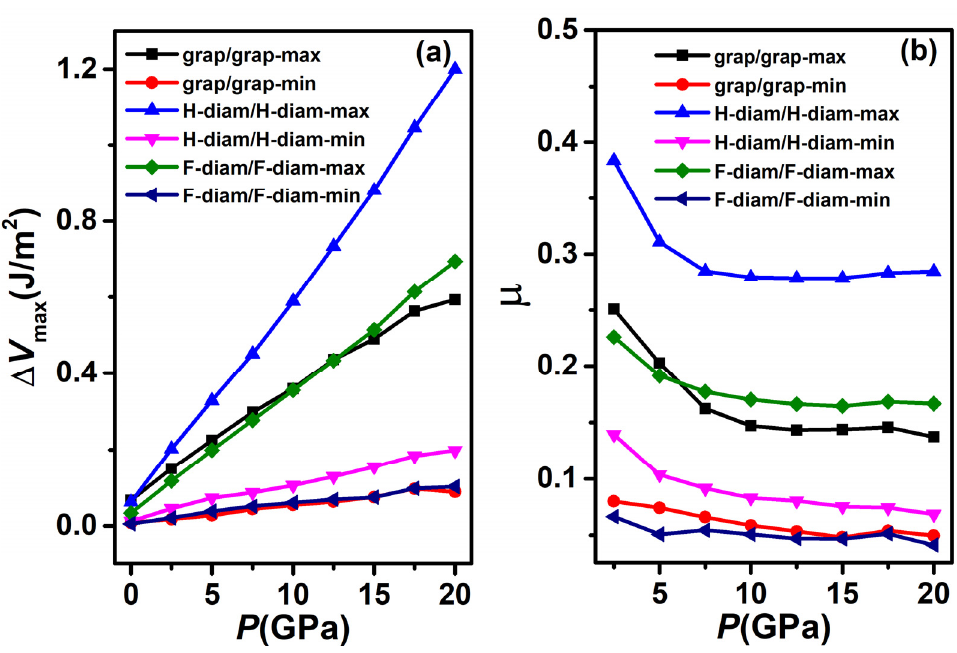
Figure 7. ( a ) Potential energy barrier Δ V max and ( b ) coefficient of friction μ along both of minimum and maximum barrier paths under different loads P for graphene–graphene, H-diam/H-diam, and ( b ) F-diam/F-diam systems.